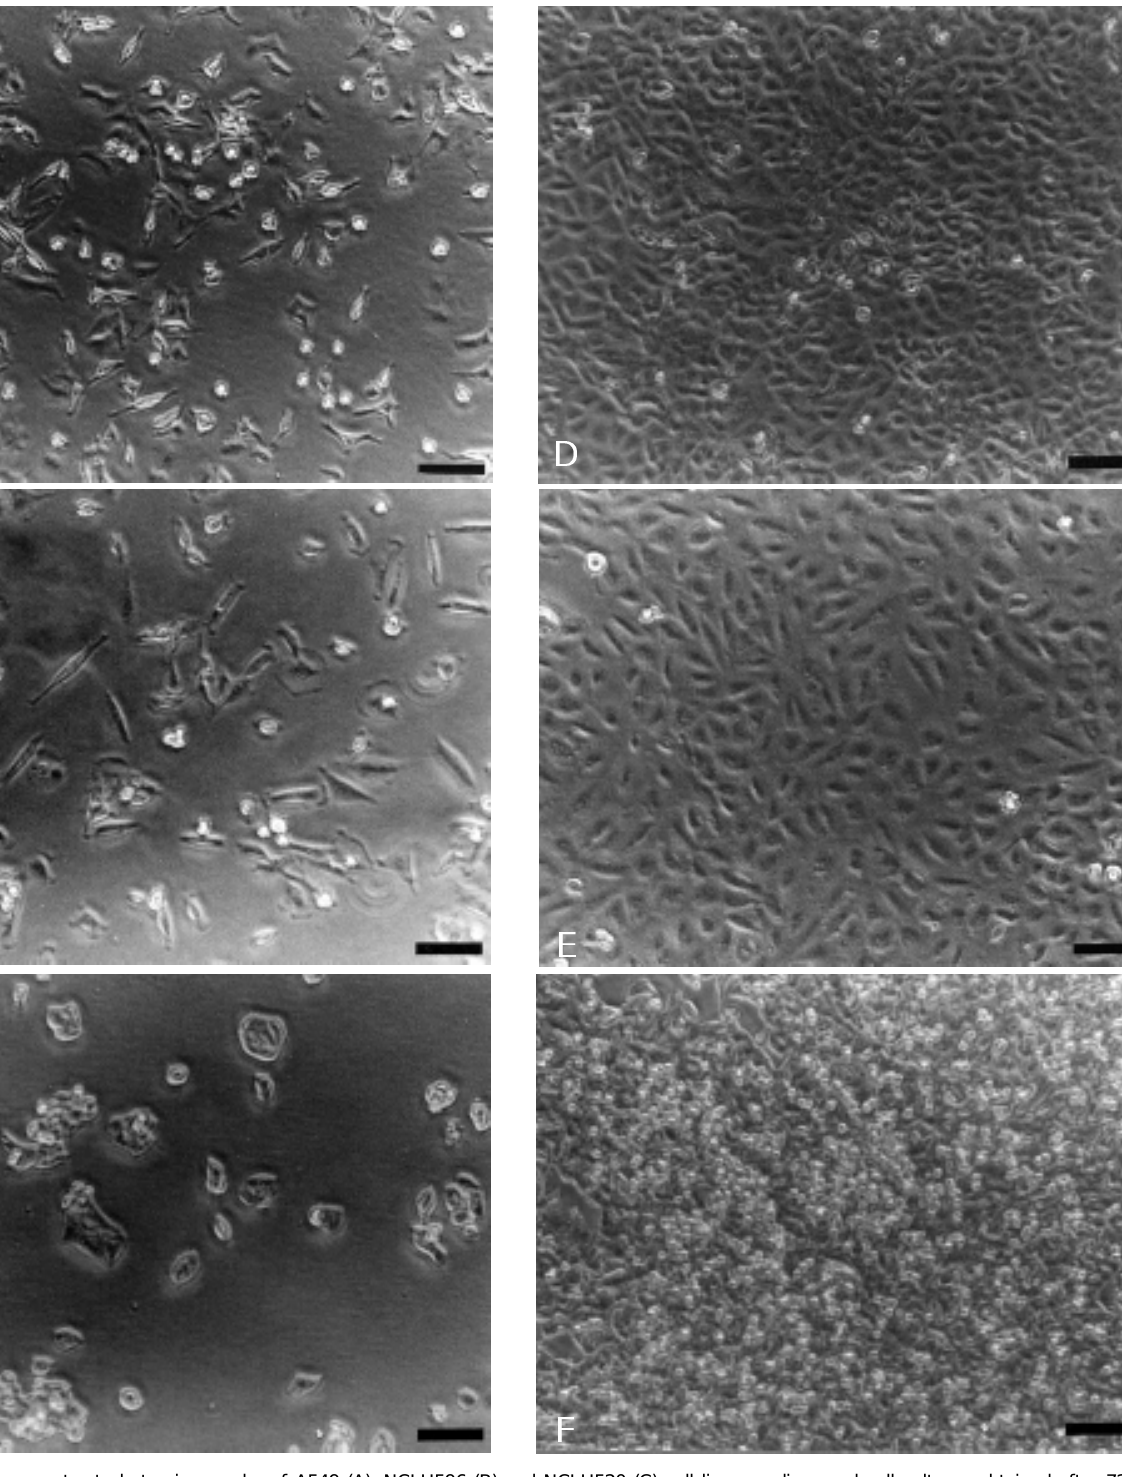
Figure 1. Phase contrast photomicrographs of A549 (A), NCI-H596 (B) and NCI-H520 (C) cell lines as dispersed cell cultures obtained after 72-h incubation. Confluent cell cultures of A549, NCI-H596 and NCI-H520 after 72 h are shown in panels D, E and F, respectively. The bar length indicates approximately 100